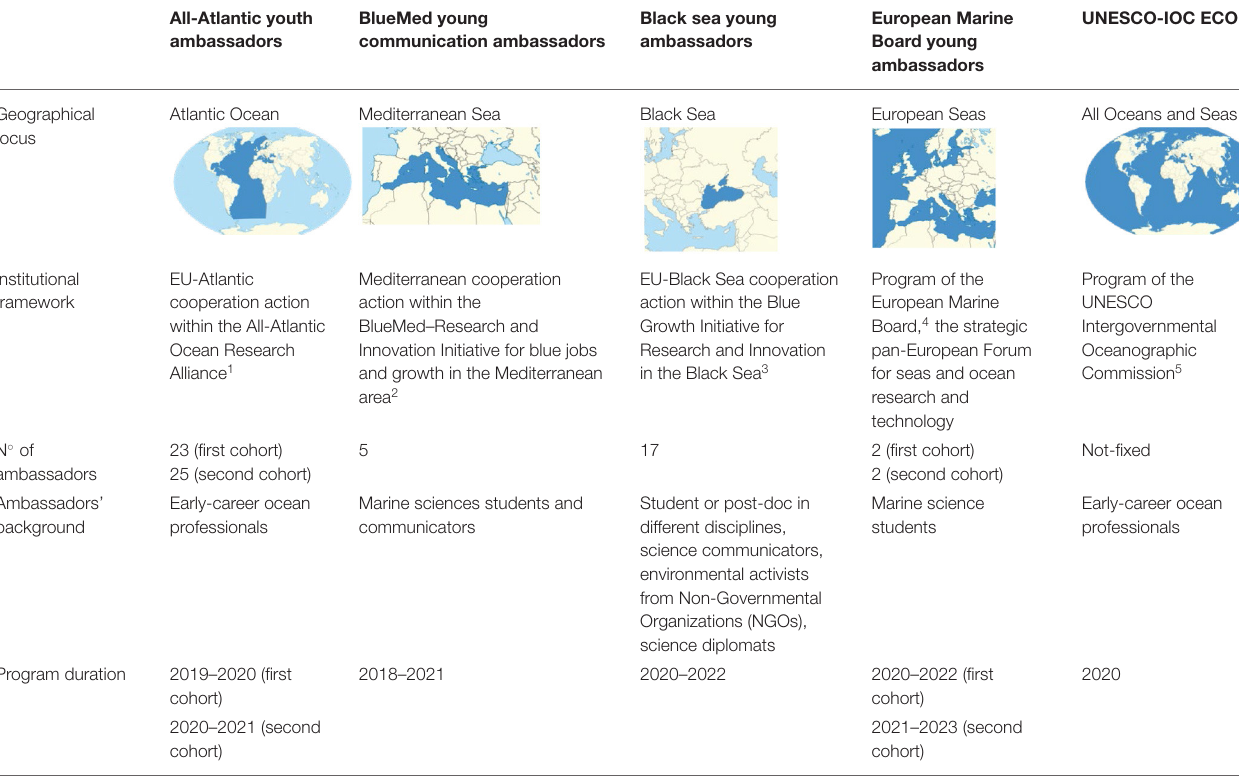
TABLE 1 | A comparison of the main features of selected marine ambassadors’